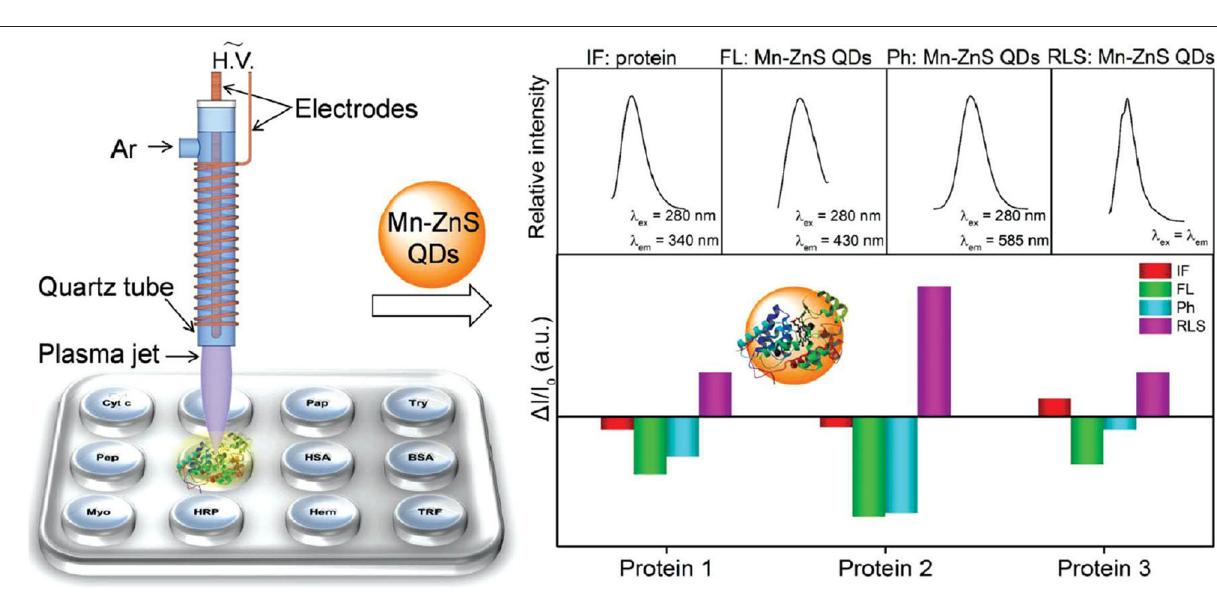
FIGURE 12 | Schematic representation of the plasma-assisted quadruple-channel sensing device for protein discrimination. Reprinted from Li et al. (2016) with